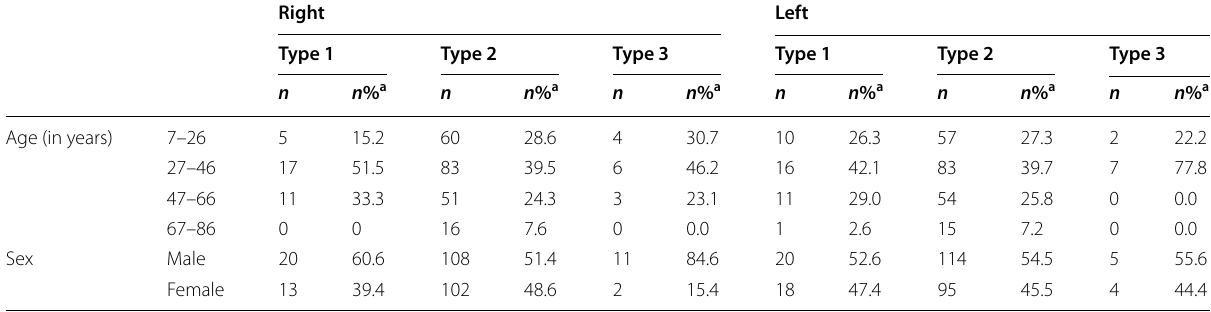
Table 2 Distribution of Keros classification according to the sides and age and sex of the patients